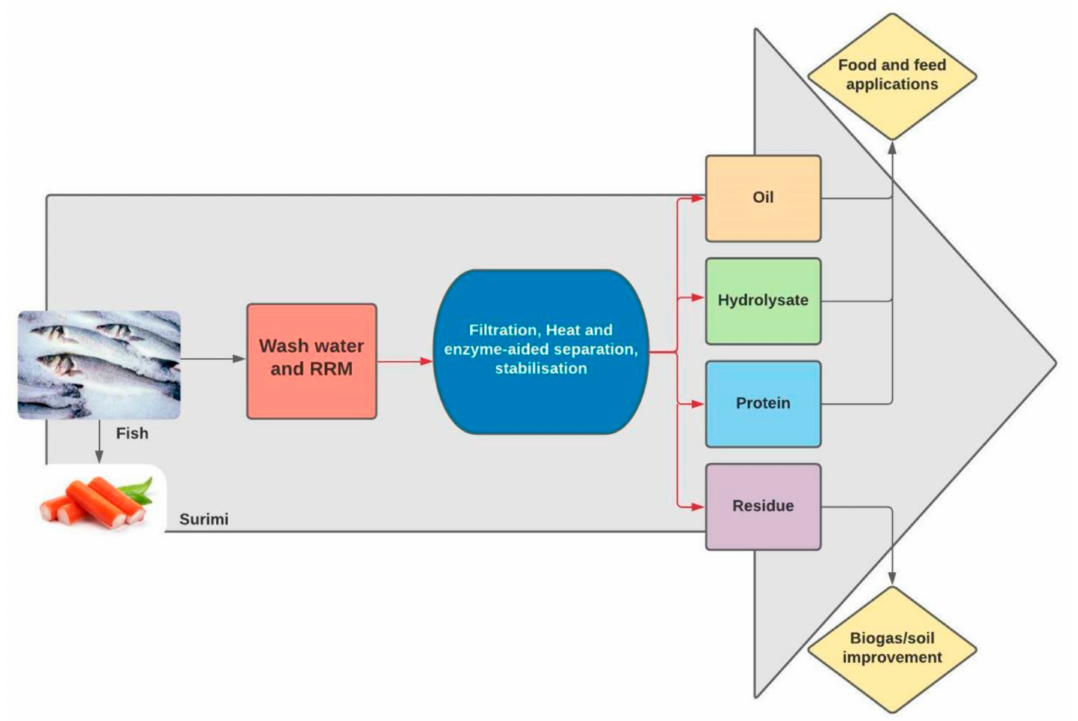
Figure 5. Possible value-added products obtained during surimi